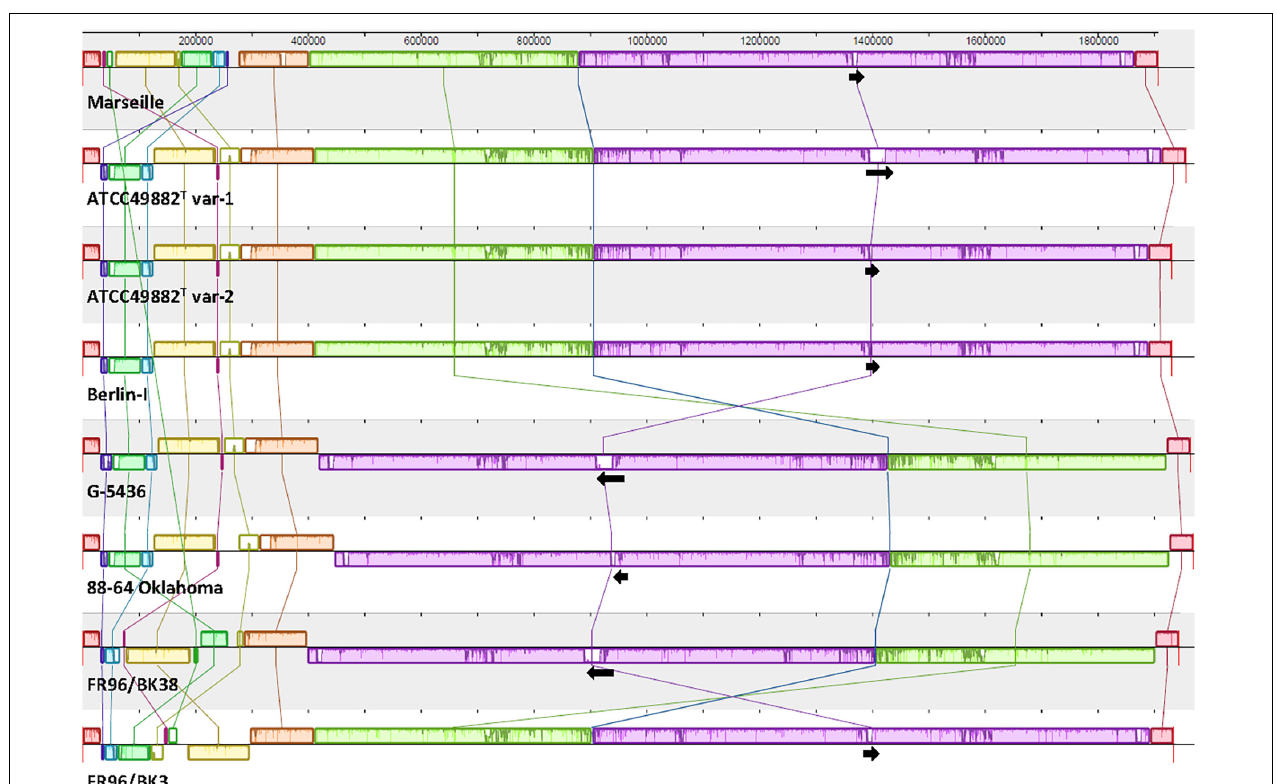
FIGURE 1 | Comparative genome alignment of eight B. henselae strains. A genome alignment, visualised via progressiveMAUVE, displays a conserved B. henselae genome sequence with few inversions, mostly located in the first ca. 300,000 bp. Genomes are shown as horizontal panels following a black line. Coloured blocks and vertical lines depict localised collinear regions of the genome sequence that align to part of another genome, are homologous, and are internally free from genomic rearrangements. Blocks above or below the horizontal line are in the same or reverse complement orientation compared to the reference genome of B. henselae Marseille, respectively. Regions outside blocks lack detectable homology. Inside each block, a similarity profile of the genome sequence is drawn. The height of this profile corresponds to the average level of conservation in that particular region. Complete white areas are not aligned and probably contain sequence elements specific to that strain genome. Black arrows indicate the length, orientation and position of the badA island within each genome sequence. The upper scale gives sequence coordinates.